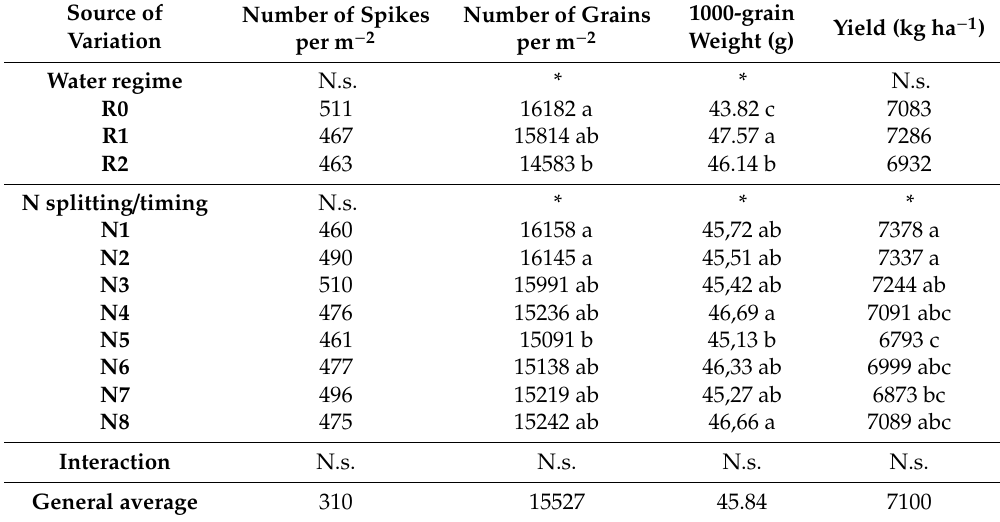
Table 3. E ff ect of the water regime and nitrogen fertilizer type / splitting / timing on number of spikes per m − 2 , number of grains per m − 2 , 1000-grain weight (g), and yield (kg ha − 1 ; corrected to 12% moisture) in 2017 /